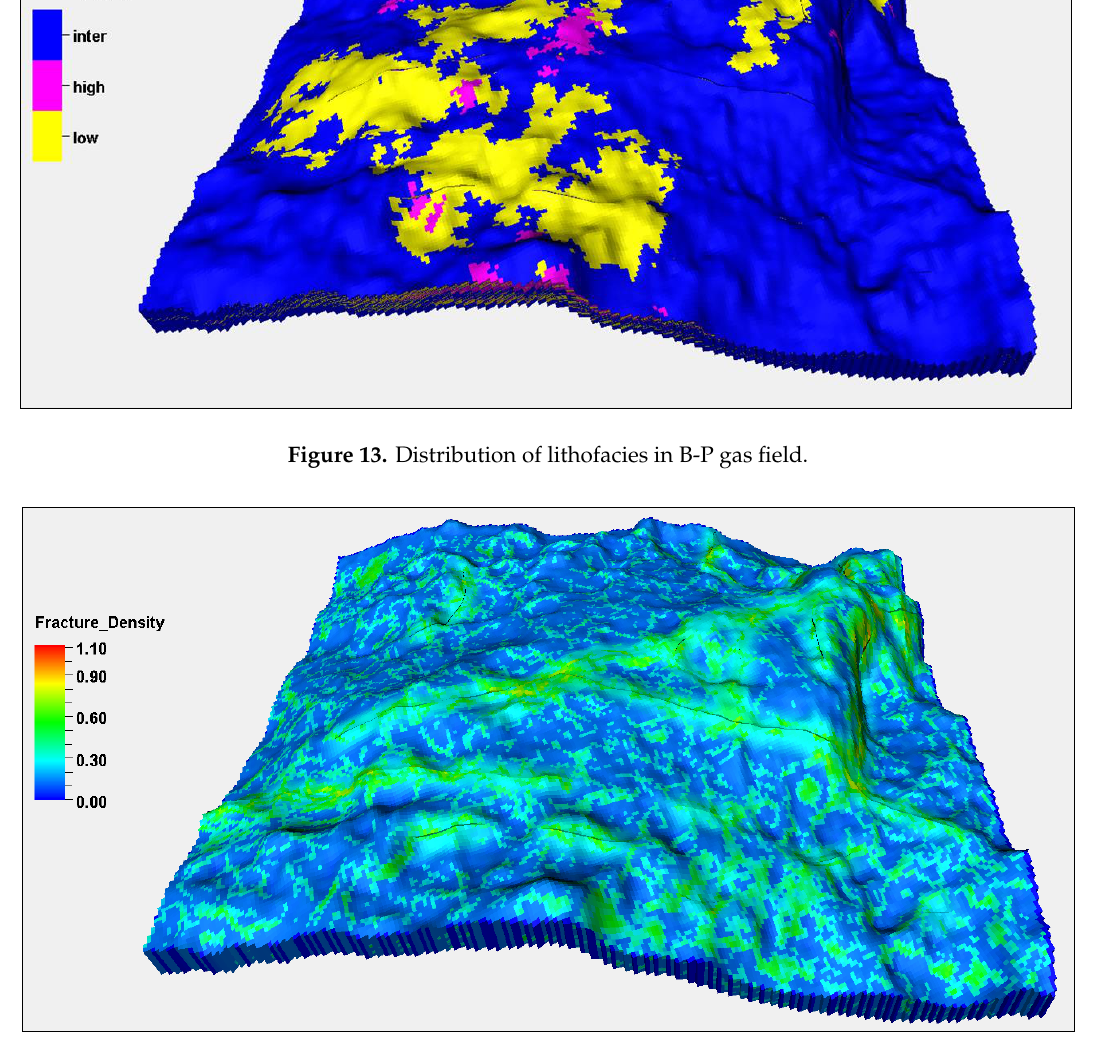
Figure 14. Fracture density model in B-P gas field.